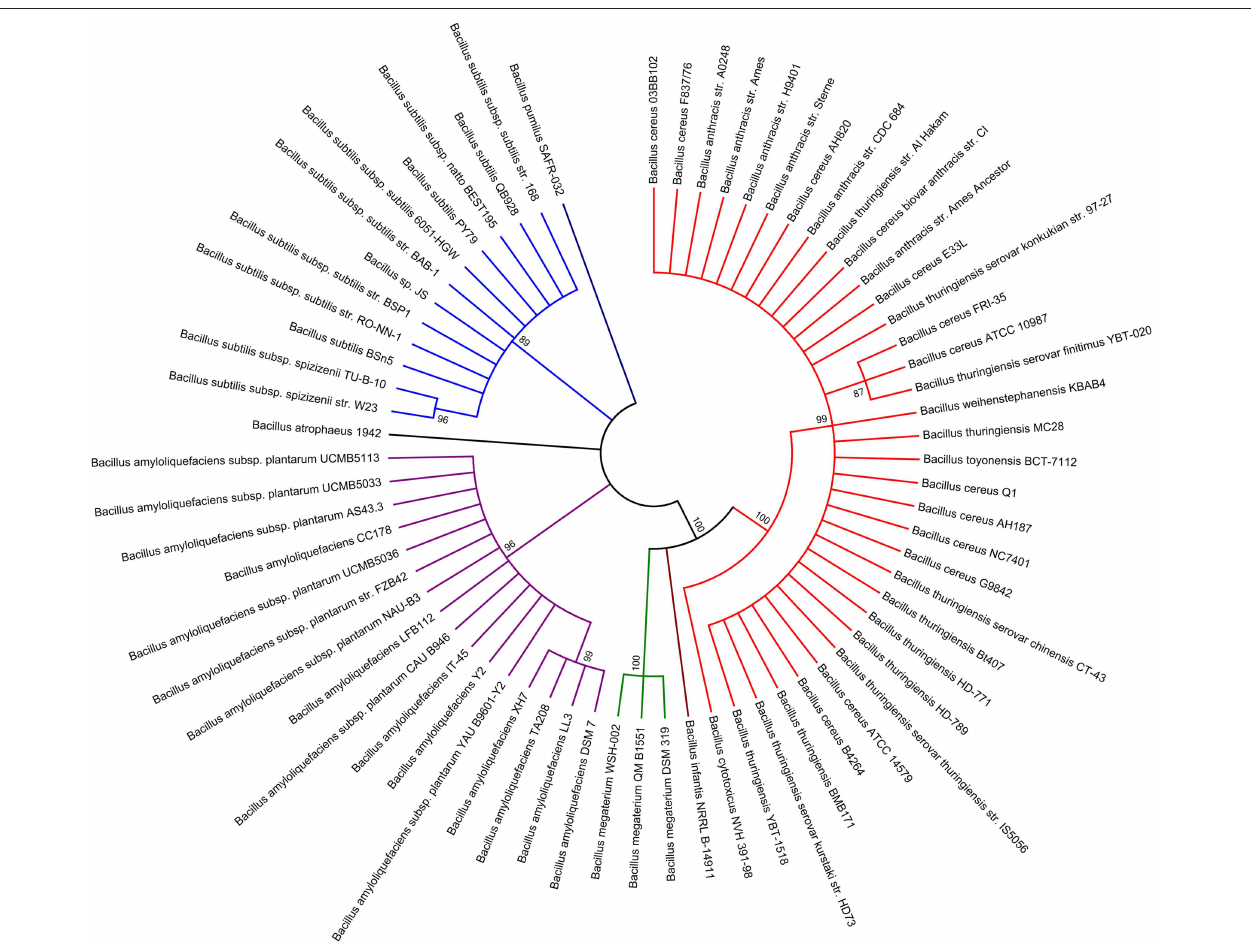
FIGURE 8 | Phylogenetic distribution of the CdaS proteins in the genus Bacillus . The analysis involved 68 CdaS amino acid sequences from each of 68 strains of the genus Bacillus with available genome reference sequences. The individual groups are demarcated with different colors, red: B. cereus group, Group I; brown: B. infantis , Group II; green: B. megaterium , Group III; purple: B. amyloliquefaciens , Group IV; dark: B. atrophaeus ; Group V; blue: B. subtilis , Group VI, dark blue: B. pumilus , Group VII.